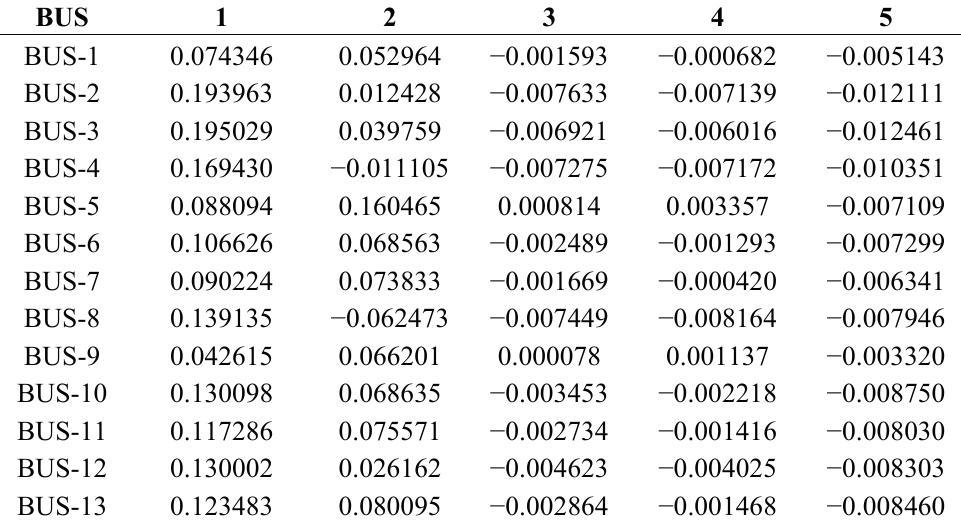
Table 3. The fault coefficient in symmetrical short circuit